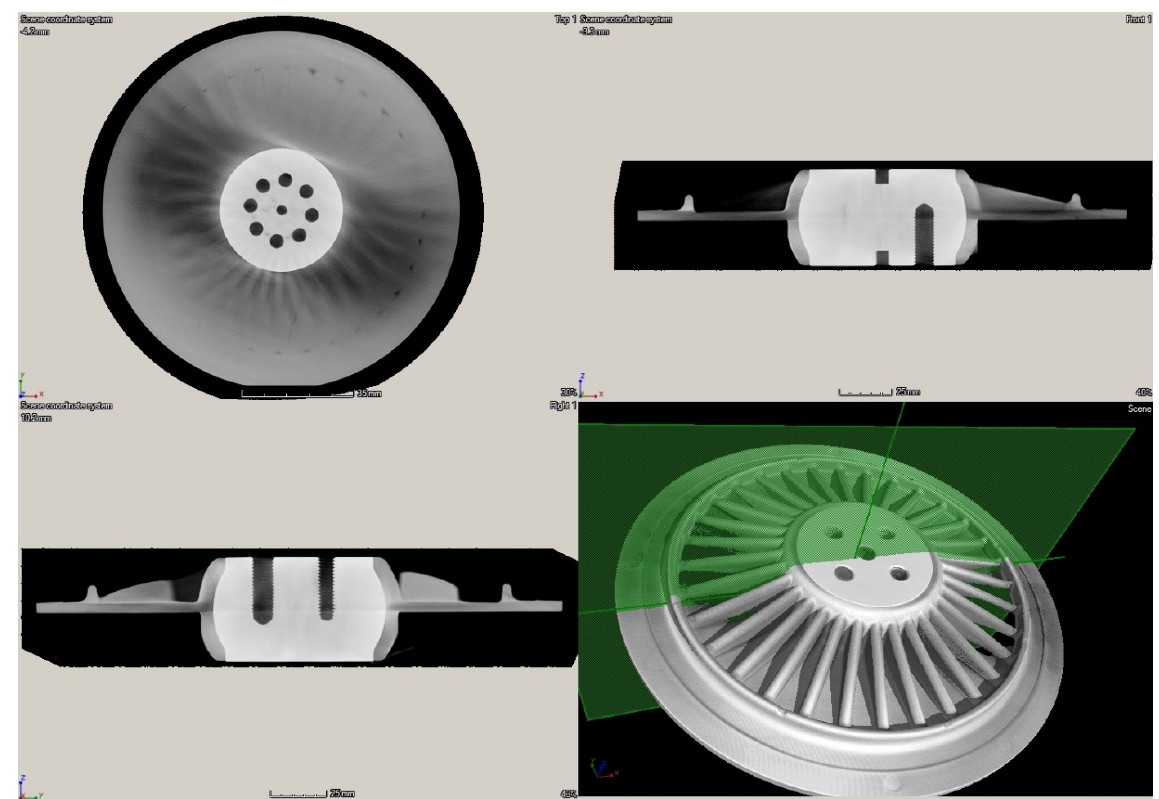
Figure 16. The general 3D view with cross-sections of the tomogram of the larger disk.